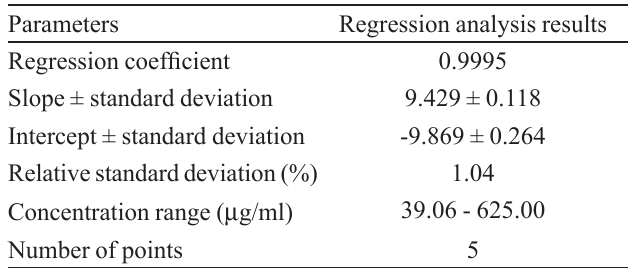
TABLE I - Overview of the linearity data obtained for fluconazole